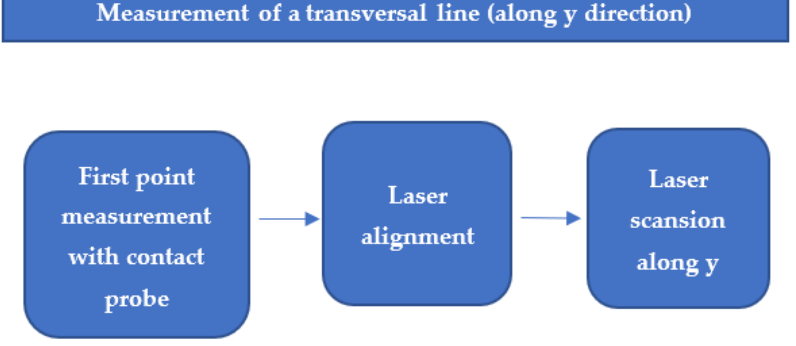
Figure 7. A diagram to represent each step of a transversal line measurement.